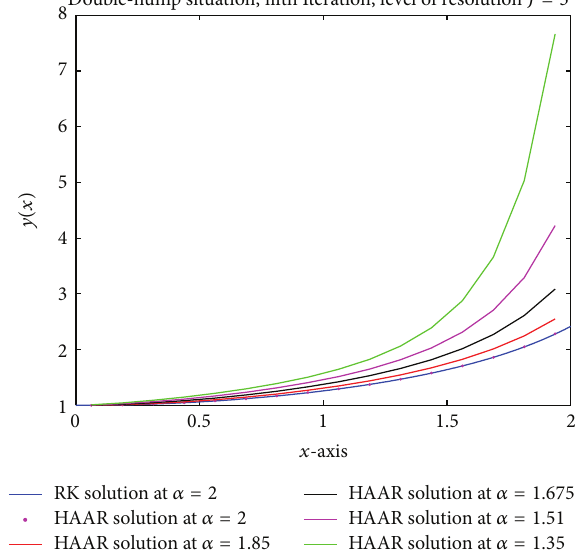
Figure 3: Solution by RK method (RK Solution) at 𝛼 = 2 and solution by Haar wavelet-quasilinearization technique (HAAR Solution) at 𝐽 = 5 and different values of 𝛼 for 𝑎 = 0.5 , 𝑏 = −0.5 , 𝜇 = 0.1 , 𝑓 = 0.5 , and 𝜔 = 0.79 .